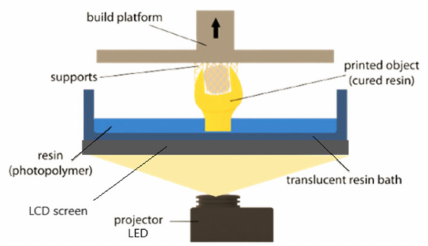
Figure 2. Schematic illustration of an LCD printer fabrication process.